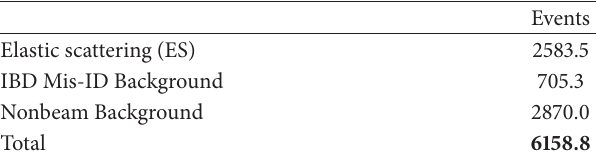
Table 3: Total signal and background events in KamLAND with 𝐸 between 3 and 12MeV given the IsoDAR assumptions in Table 2 and the selection cuts outlined in text.